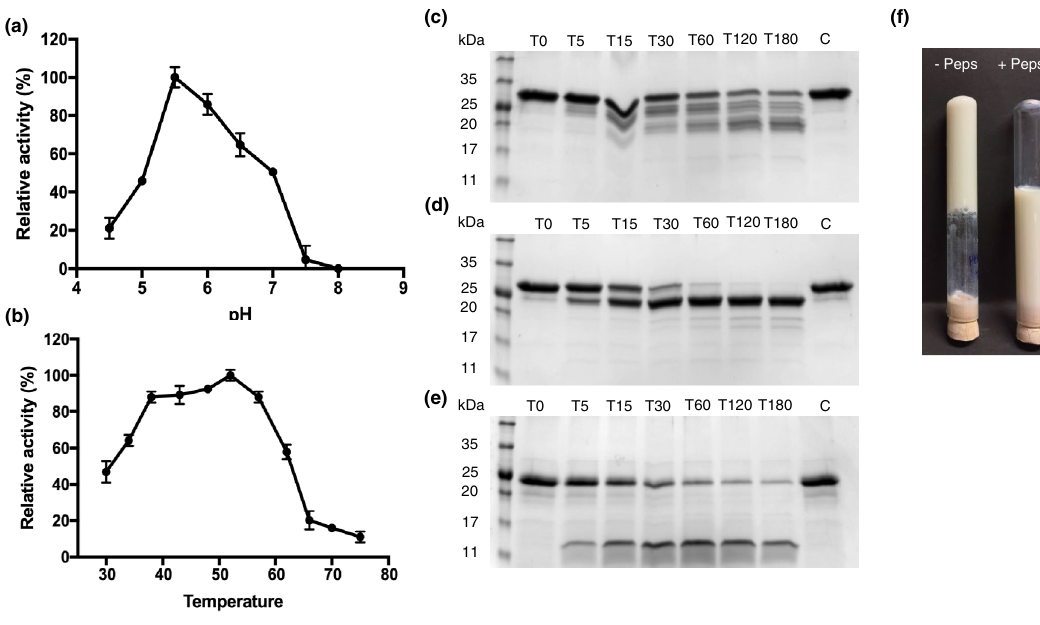
Figure 3. Characterization of proteolytic activity of purified cardosin B towards azocasein and caseins. ( a ) Determination of optimal pH ( b ) Determination of optimal temperature ( c , d , e ) SDS-PAGE analysis of α-casein, β-casein and κ-casein digestion by cardosin B, time-points are represented in minutes, C represents untreated control sample taken at T180 ( f ) Milk clotting assay using purified cardosin B without and with pepstatin A. Values are the mean of three technical